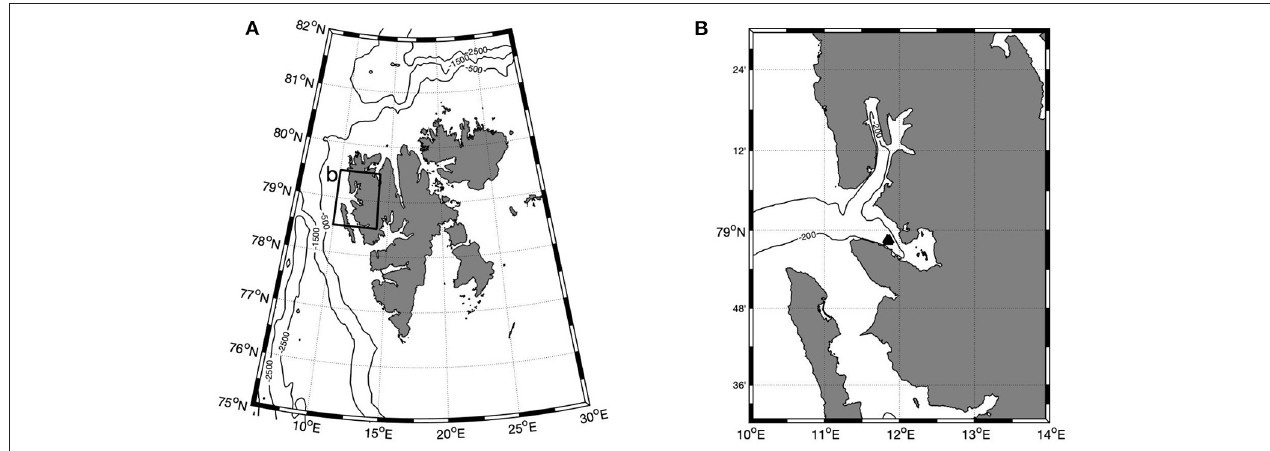
FIGURE 1 | Location of study, Kongsfjorden, at 79 ◦ N. (A) Kongsfjorden within the wider context of the Svalbard archipelago; (B) Detailed map of the Kongsfjorden/Krossfjorden fjord system with approximate location of mooring shown ( N ). Contours of water depth are shown in m.